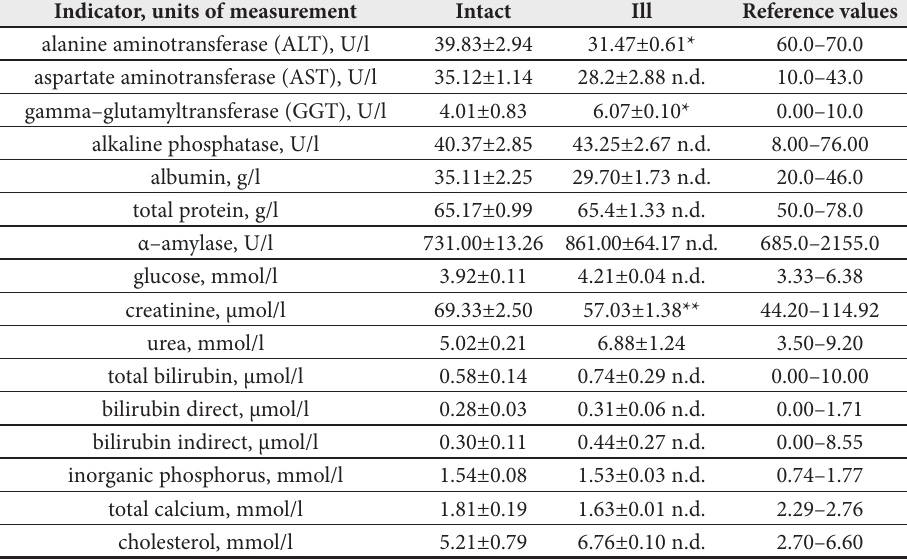
Biochemical parameters of serum of intact dogs and atopic dermatitis, M ± m , n = 5 Indicator, units of